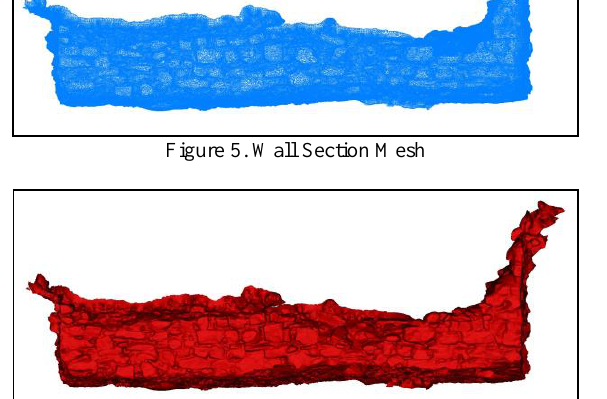
Figure 6. Wall Section Surface